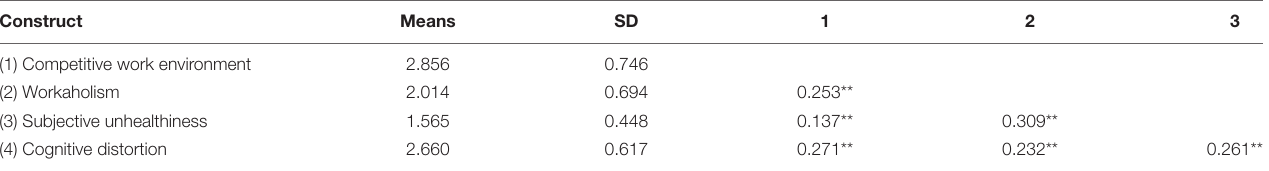
TABLE 1 | Means and correlations. Construct